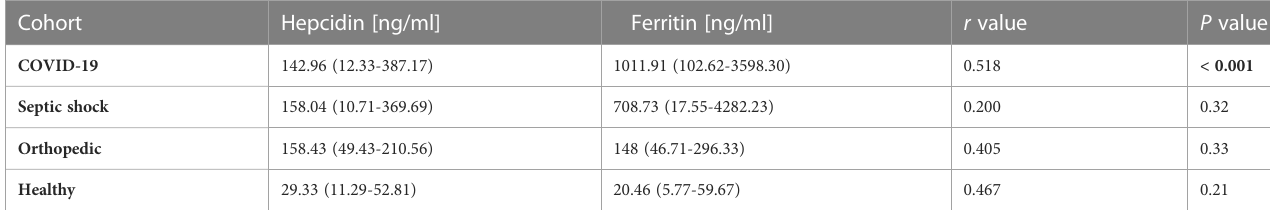
TABLE 2 Correlation between hepcidin and ferritin levels at TP1 in each cohort. Cohort Hepcidin [ng/ml] Ferritin [ng/ml] r value P value COVID-19 < 0.001 Septic shock Orthopedic Healthy Hepcidin and ferritin plasma levels are shown as mean (range) for each cohort. Bolded text = statistically signi fi cant correlation. r = Spearman ’ s correlation coef fi cient.